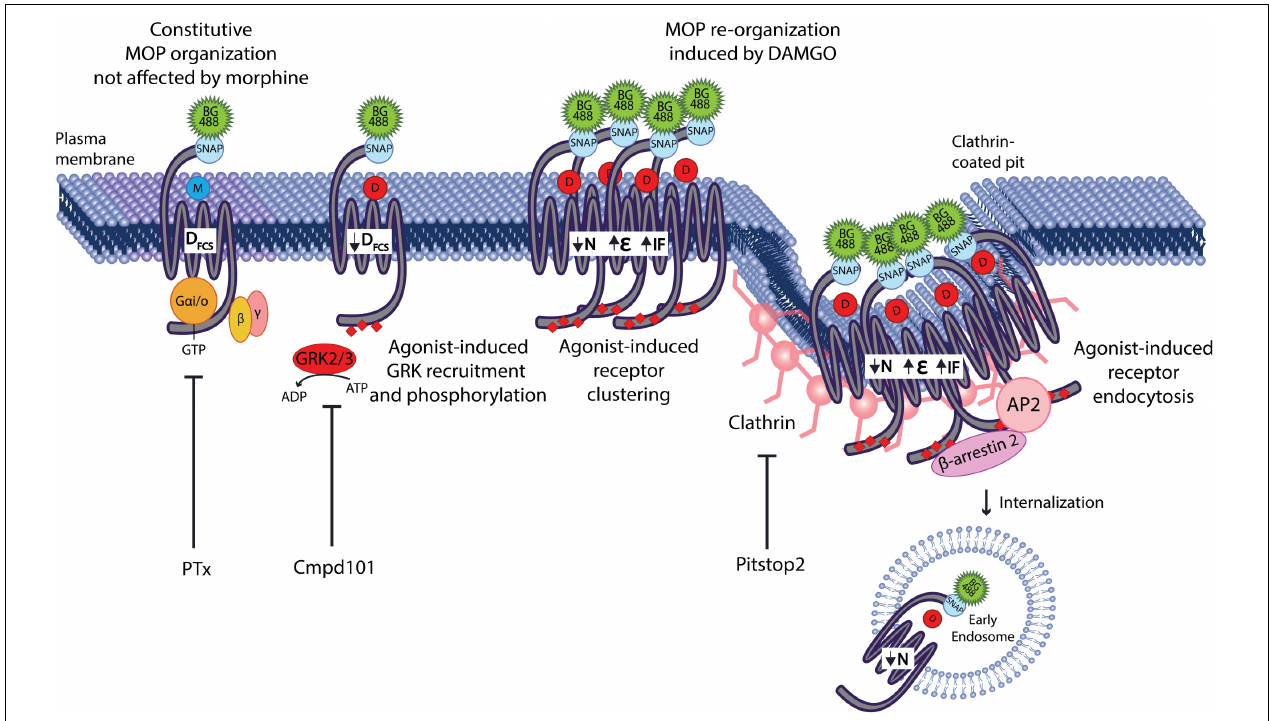
FIGURE 6 | GRK2 mediates MOP micro-diffusion events that precede internalization. Agonist stimulation of SNAP-MOP with morphine does not alter its constitutive plasma membrane organization. In contrast, agonist stimulation with DAMGO causes re-organization of SNAP-MOP indicated by the decrease in diffusion coefficient (D FCS ), the decrease in particle concentration (N), the increase in molecular brightness ( ε ), and the increase in immobile fraction (IF). G protein activation is not involved in SNAP-MOP plasma membrane organization, whereas GRK2/3 activity mediates DAMGO-induced slowing in D FCS independent or prior to clustering and movement of SNAP-MOP into clathrin-coated pits to proceed toward internalization. The latter events are responsible for changes in macro-scale parameters such as the reduced N, increased ε and